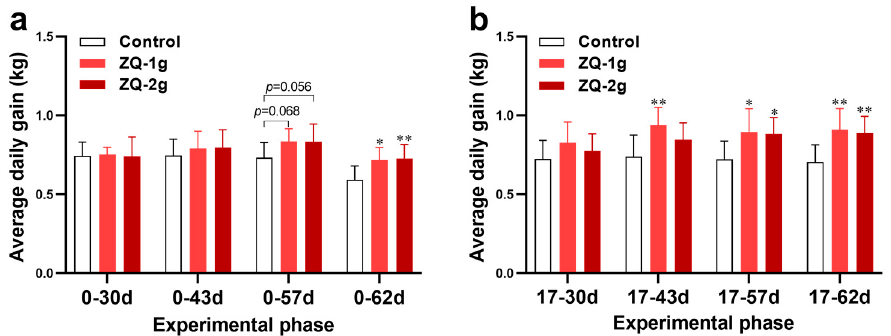
Figure 2. Growth curve of pigs. Note: * indicates a significant difference when the values were compared to that of the control ( p < 0.05).